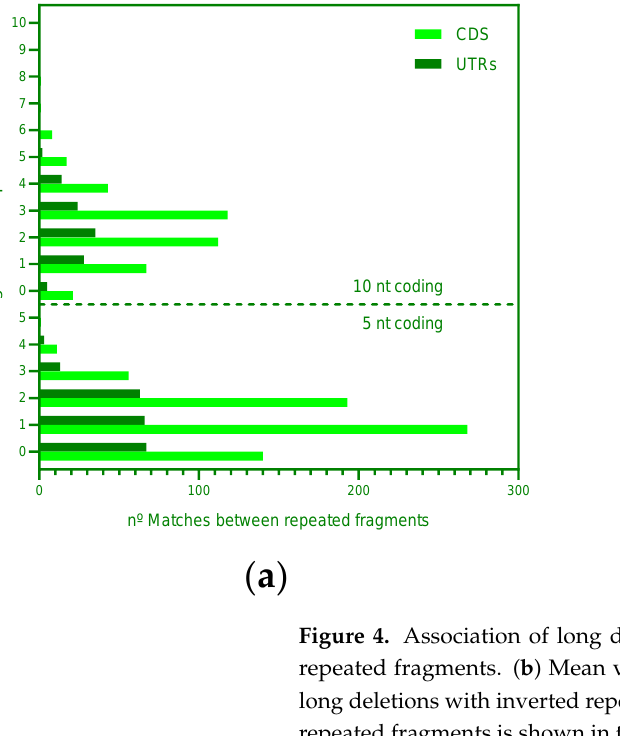
Figure 3. Association of long deletions with direct repeats. ( a ) Number of matches between repeated fragments. ( b ) Mean values for the generated deletions. Heatmap of the association of long deletions with direct repeats in UTR and CDS expressed as the number of matches between repeated fragments is shown in the Figure S5.